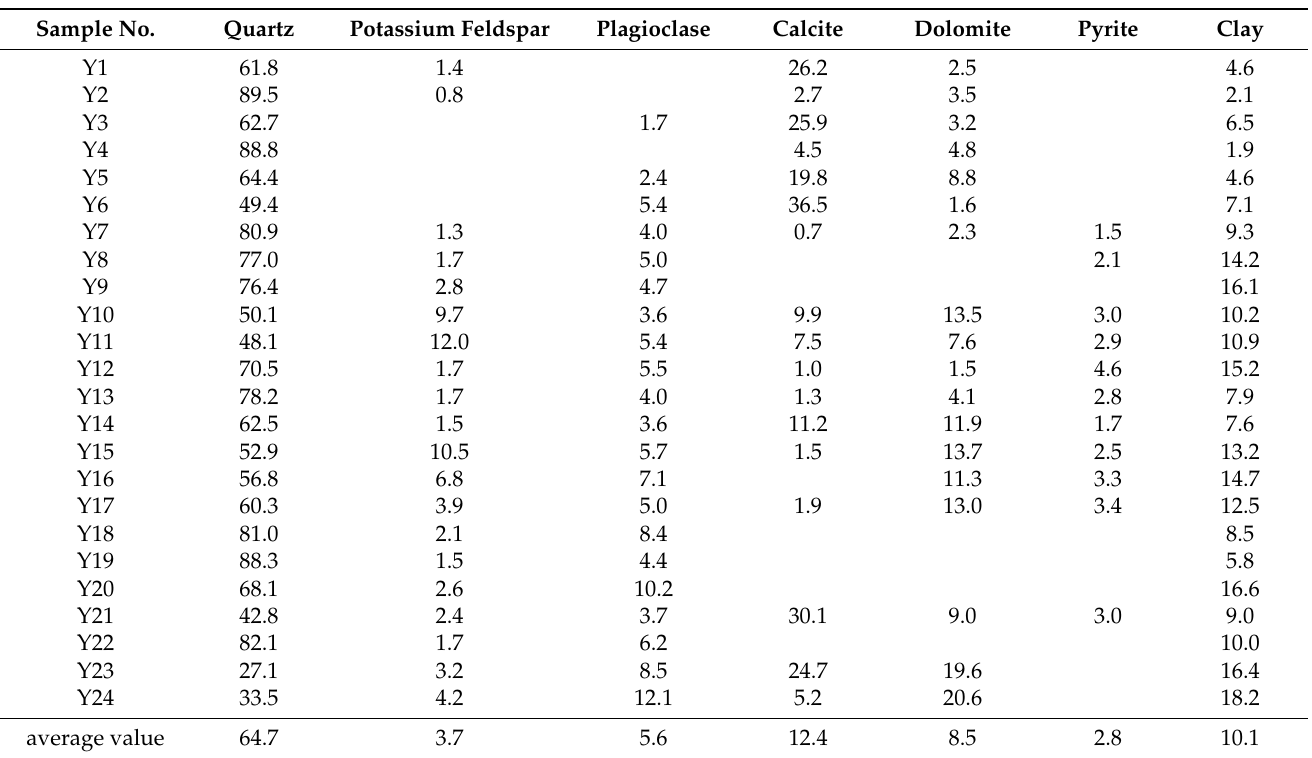
Table 1. Mineral compositions by X-ray diffraction analysis of samples from the Longmaxi Formation from the Yanyuan Basin (10 − 2